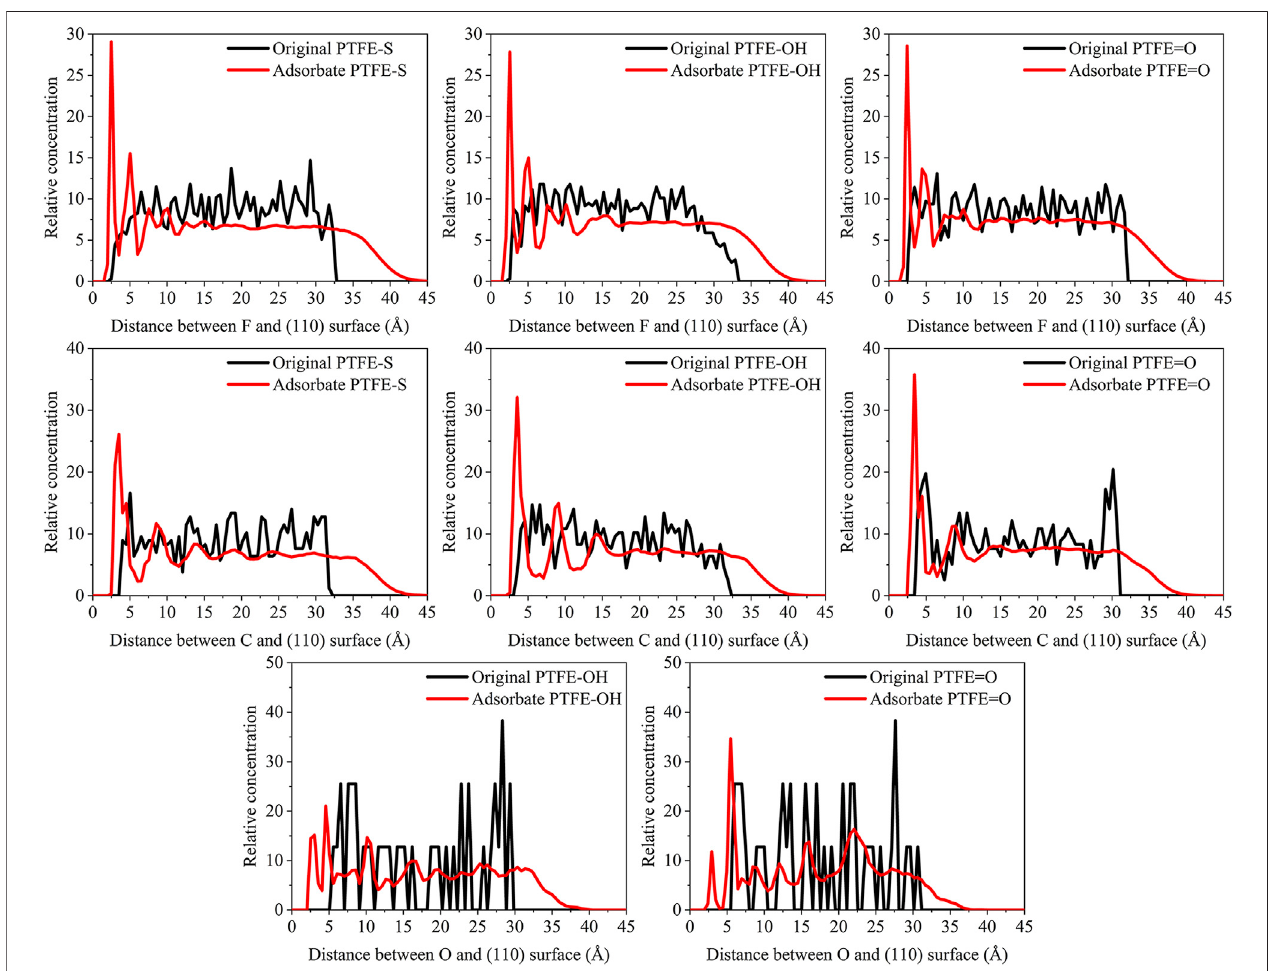
FIGURE 7 | Concentration distribution of F, C, and O atoms along z-axis for the (110)/PTFE-S, (110)/PTFE-OH, and (110)/PTFE (cid:2) O interface systems.